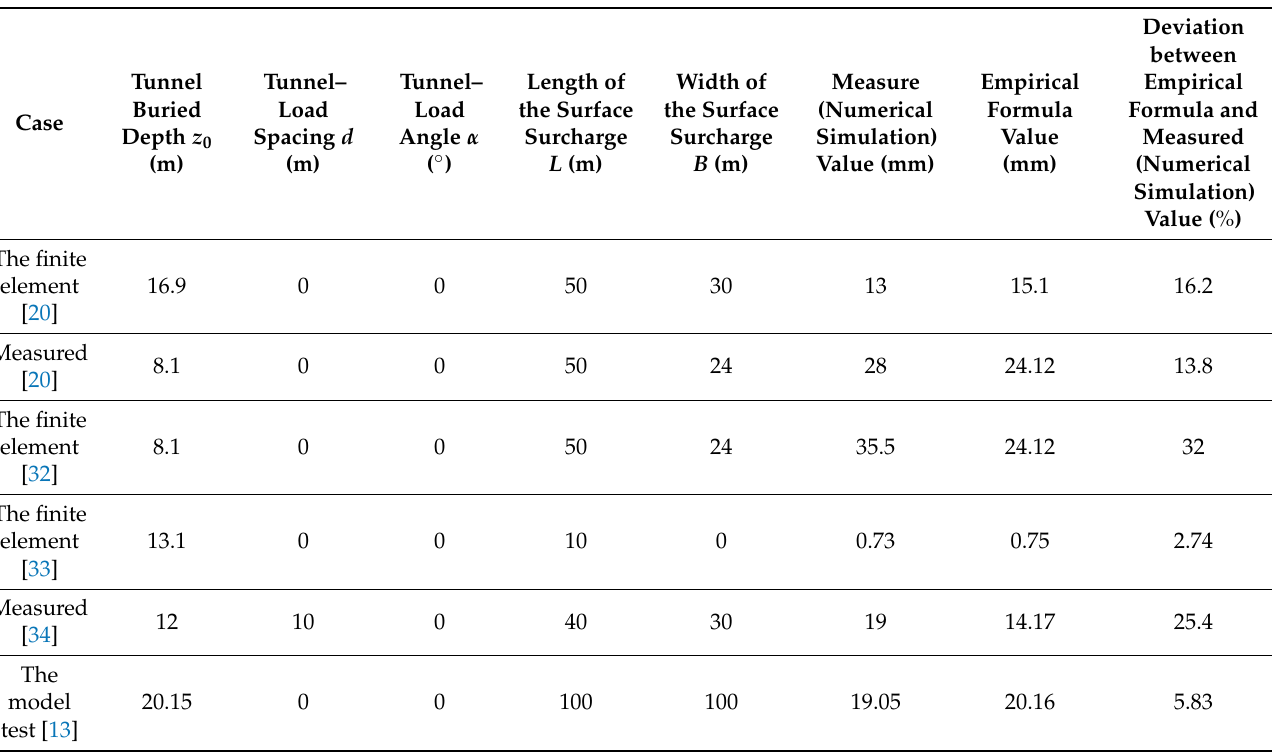
Table 5. Case (numerical simulation)